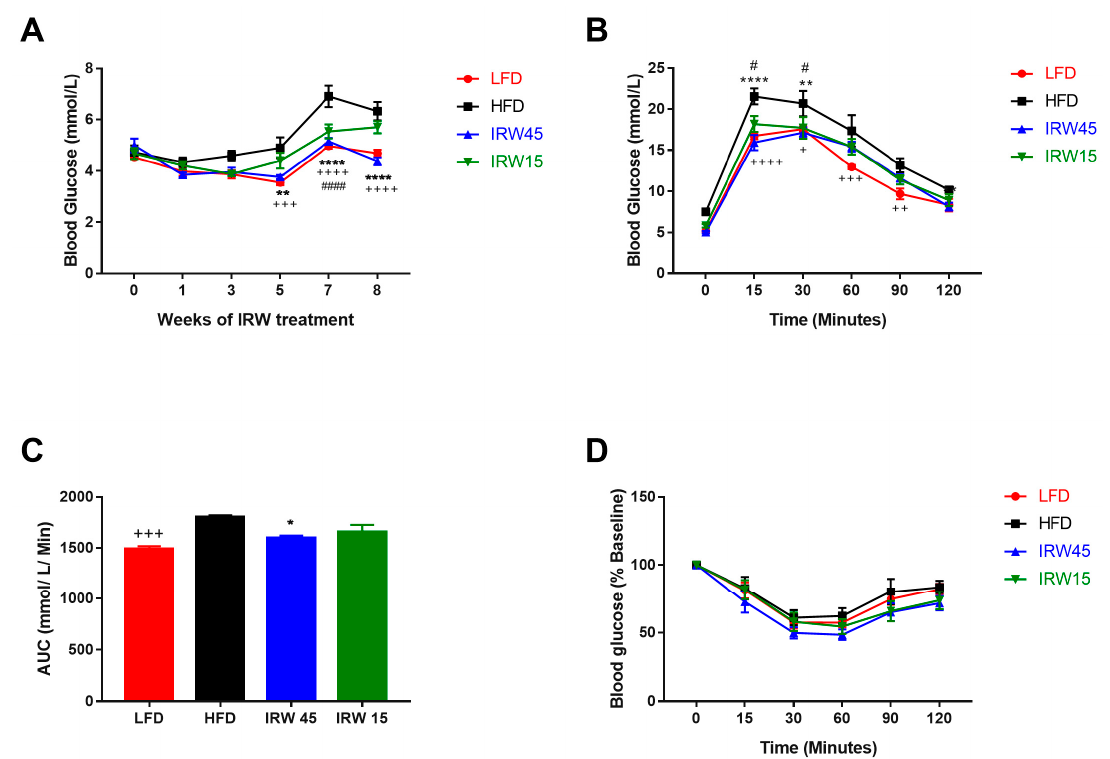
Figure 1. Glucose homeostasis after IRW supplementation. ( A ) Fasting glucose over time (n = 6–8), ( B ) Oral glucose tolerance test (OGTT) (n = 6–8). ( C ) Area under the curve (AUC) for OGTT (n = 5–8). ( D ) Insulin tolerance test (ITT) as percentage of the baseline glucose values (n = 8). Data expressed